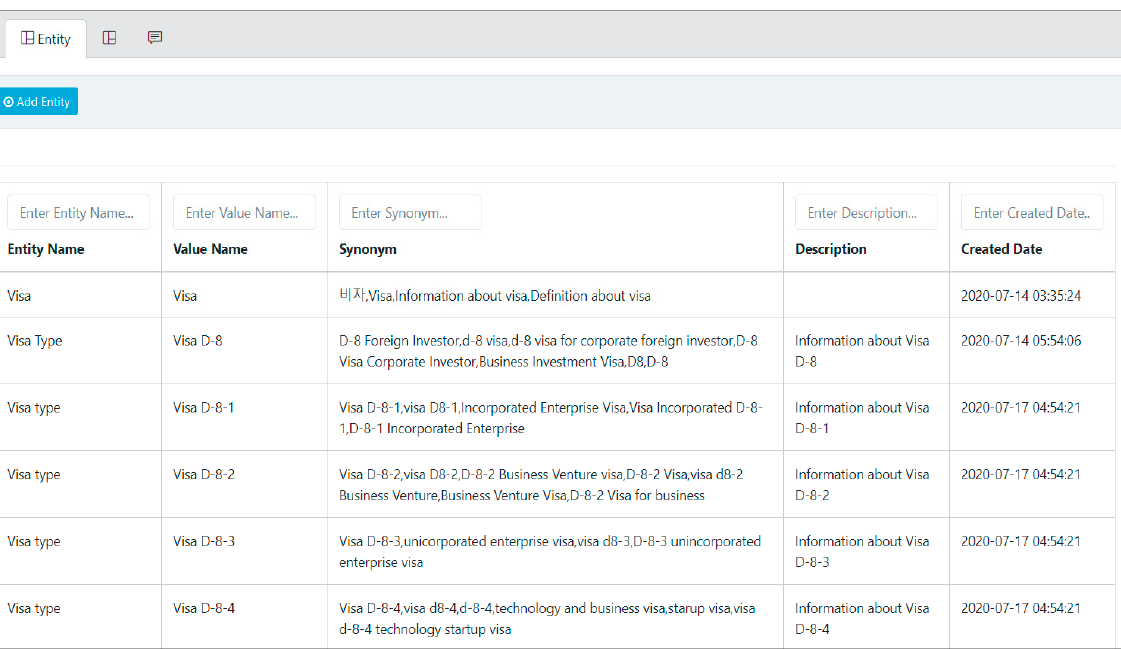
Figure 15. Data set sample of Entity.